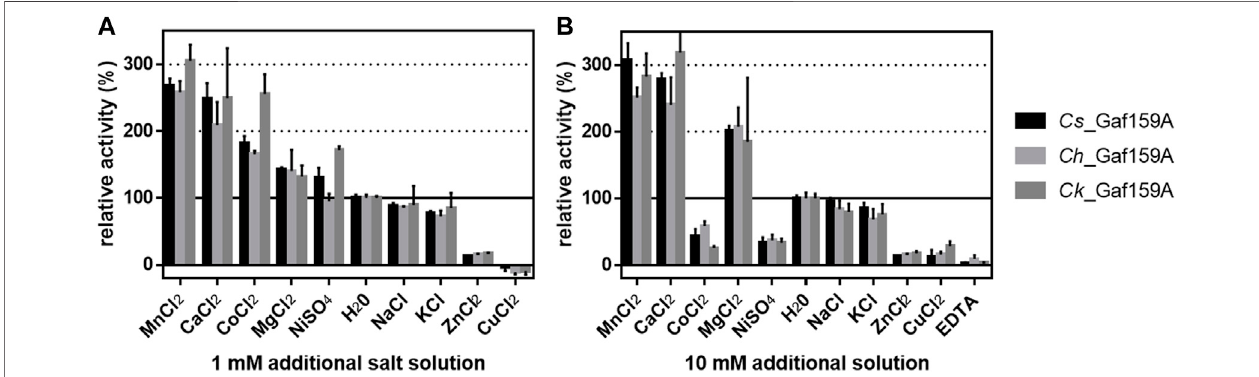
FIGURE 3 | In fl uence of additional salt solutions on the activity of Cs _Gaf159A, Ch _Gaf159A and Ck _Gaf159 on p NPA. Reactions contained 1 mM pNPA, 5 µg enzyme (0.2 µg μ l − 1 stocks stored in 0.1 M MOPS pH 6.5), 0.1 M MOPS pH 6.5, and either 1 mM (A) , or 10 mM (B) additional salt solutions, and were incubated for 20 min at the respective temperature optima (90, 82 and 93 ° C for Cs , Ch and Ck ). Bars represent standard deviation from triplicates.